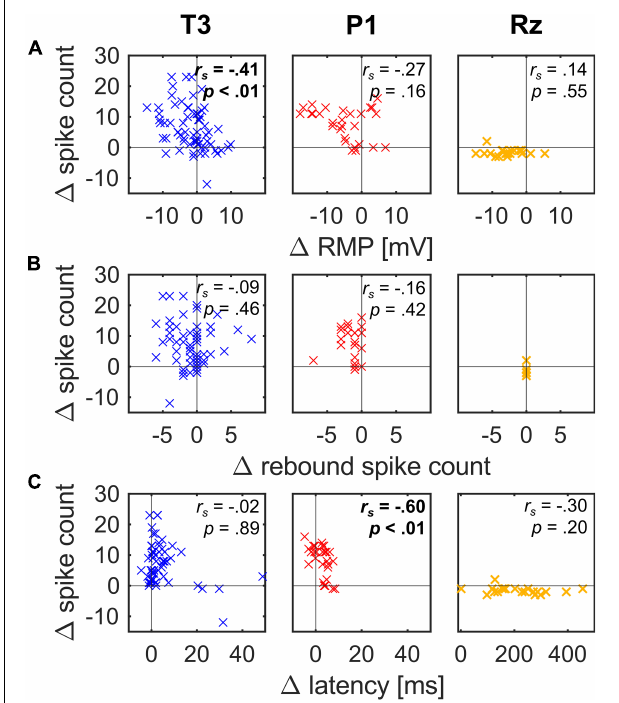
FIGURE 5 | Interdependencies between changes ( (cid:49) ) of response properties triggered by 10 min long repetition of the stimulation protocol for all three cell types. Significant correlations are marked in bold. Sample sizes, correlation coefficients and p -values are given in Table 1 . (A) The (cid:49) RMP correlated negatively with the (cid:49) spike count in T3 cells. A similar tendency was visible (but not significant) in P1 cells but absent in Rz cells. (B) The (cid:49) rebound spike count did not correlate with the (cid:49) spike count in T3 and P1 cells. Rz cells did not show any rebound spikes. (C) The (cid:49) latency correlates negatively with the (cid:49) spike count in P1 cells, but not in T3 and Rz cells. Note that the x-axis-scaling is different for Rz